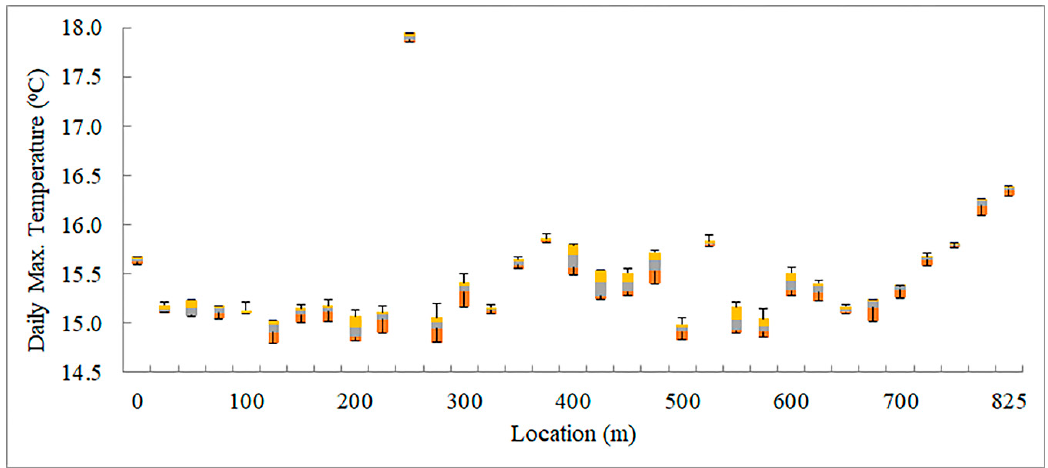
Figure 2. Minimum, maximum, 25th and 75th percentile, and median observed daily maximum temperatures (°C) per location on Little Creek from 21 to 25 August 2014.